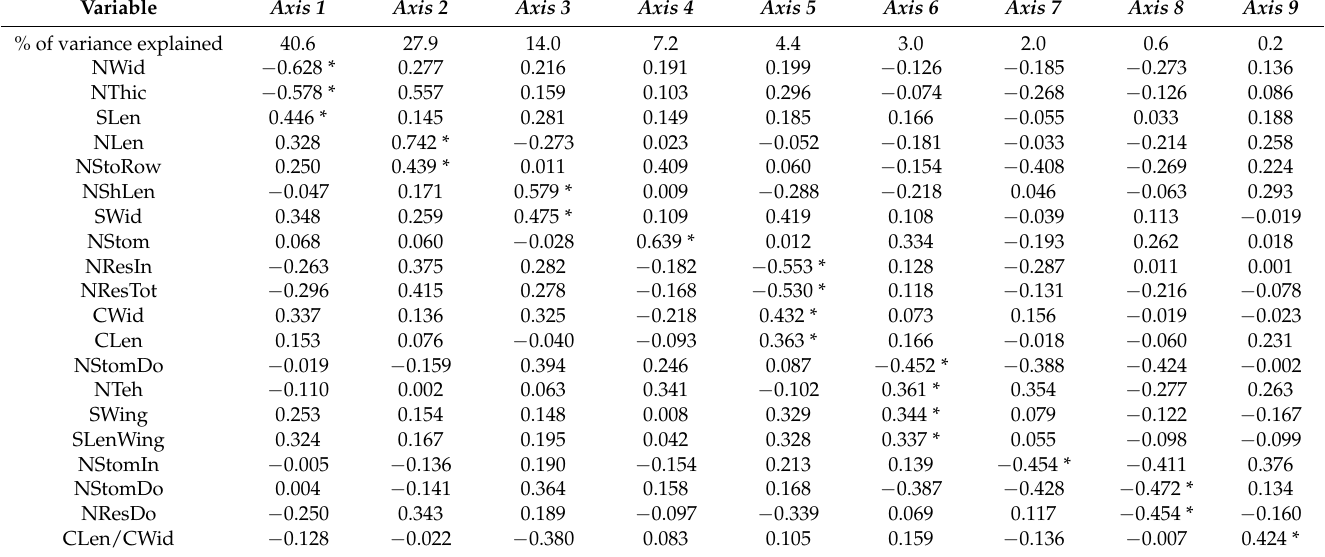
Table 6. Principal component analysis (PCA) of the 20 morphoanatomical traits of Pinus brutia in